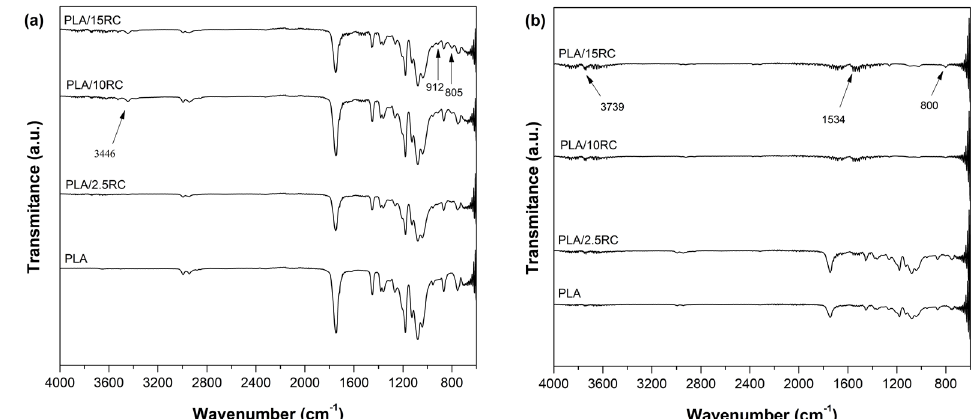
Figure 1. FTIR spectra for neat PLA and PLA/RC composites (a) before and (b) after burning